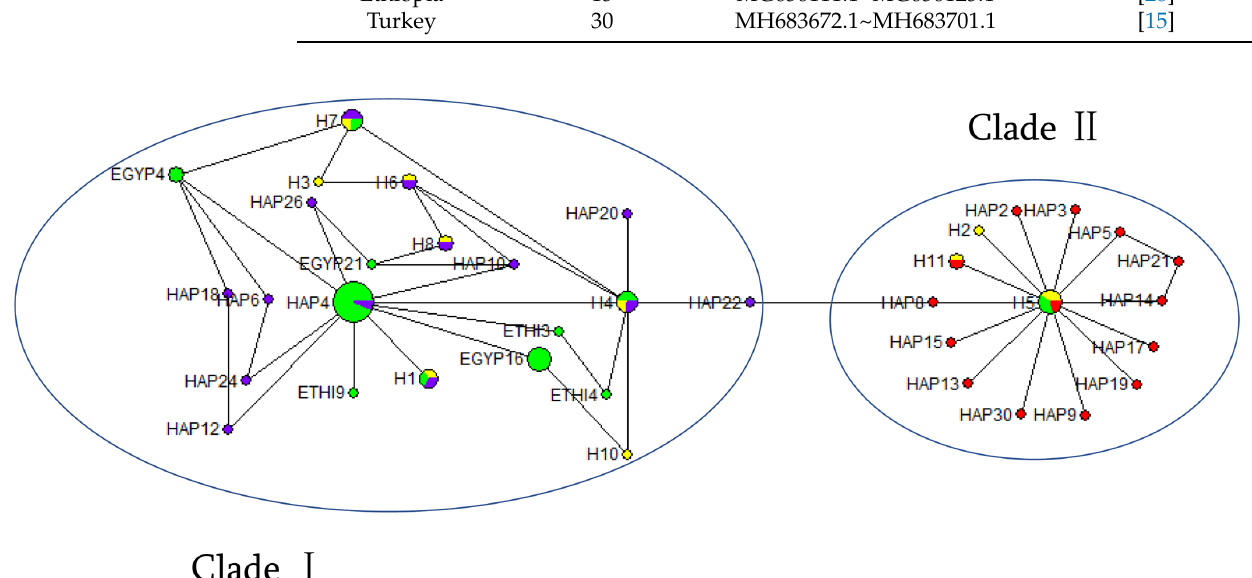
Figure 5. Median-joining network constructed from 11 haplotypes obtained from Huaibei grey donkey and 60 reference sequences obtained from 5 different populations. Note: The circle areas correspond to the haplotype frequency. Yellow circles indicate the haplotypes in this study. The green circles are 30 previously identified haplotypes [26]. The reference haplotypes Hap1~Hap30 were downloaded from NCBI [15], and the purple circles represent haplotypes belonging to Clade I (Hap4, Hap6, Hap7, Hap10, Hap12, Hap16, Hap18, Hap20, Hap22, Hap23, Hap24, Hap25, Hap26, Hap27 and Hap29), while the red circles represent Clade II haplotypes.